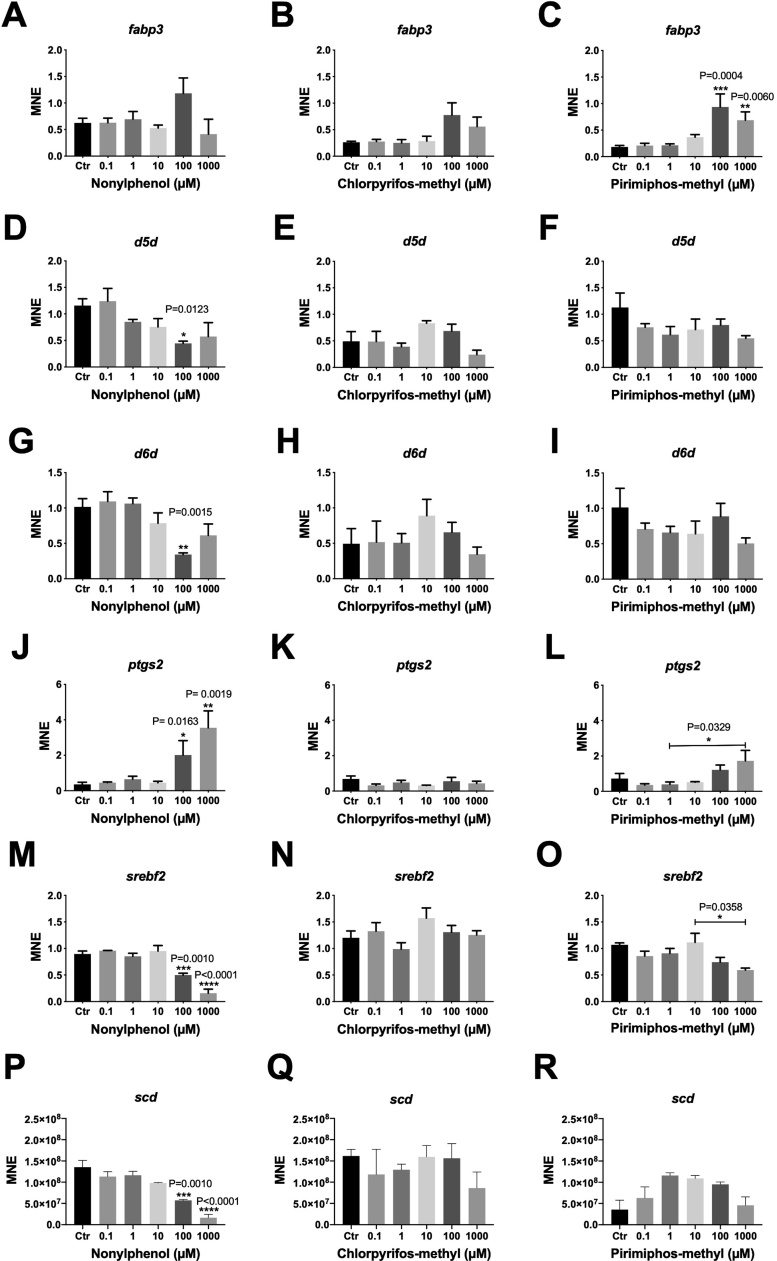
Dose-response relationships of genes associated with lipid metabolism in Atlantic salmon hepatocytes exposed to nonylphenol, chlorpyrifos-methyl and pirimiphos-methyl for 48 h. A-C) fabp3, D-F) d5d, G-I) d6d, J-L) ptgs2, M-O) srebf2, and P-R) scd. MNE = mean normalized expression. Asterisk’s denote significance based on one-way ANOVA analyses, with Holm Sidak’s posthoc test. N = 3–5. * p < 0.05 (exact p-values given in figure), ** p < 0.01, *** p < 0.001, **** p < 0.0001. Mean ± SEM.